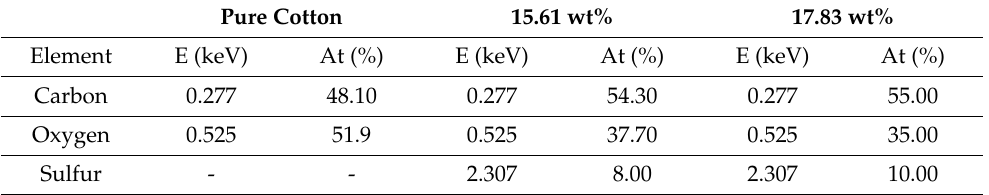
Table 1. EDX analysis of pure cotton and conductive cotton treated with the